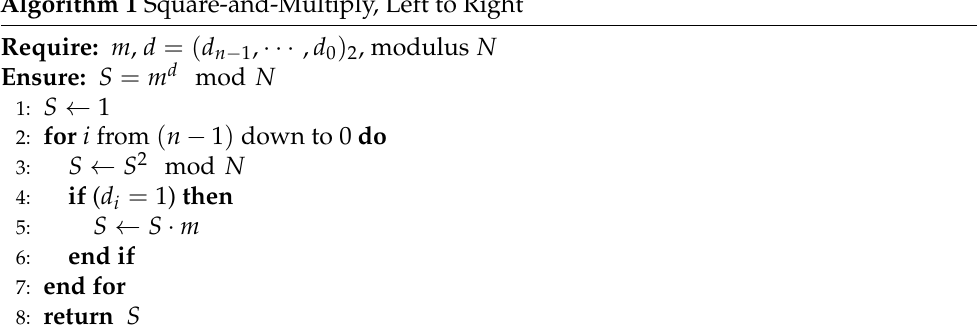
Algorithm 1 Square-and-Multiply, Left to